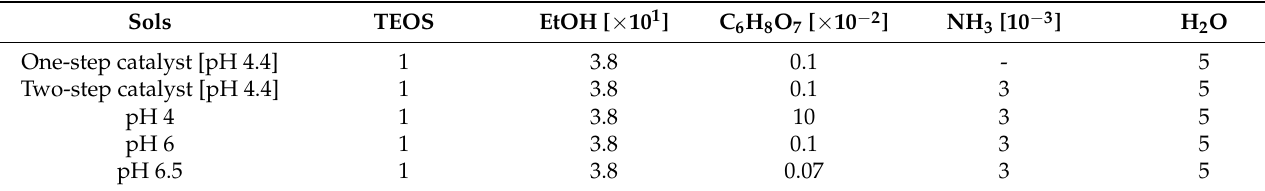
Table 1. List of final molar ratio of organo-silica